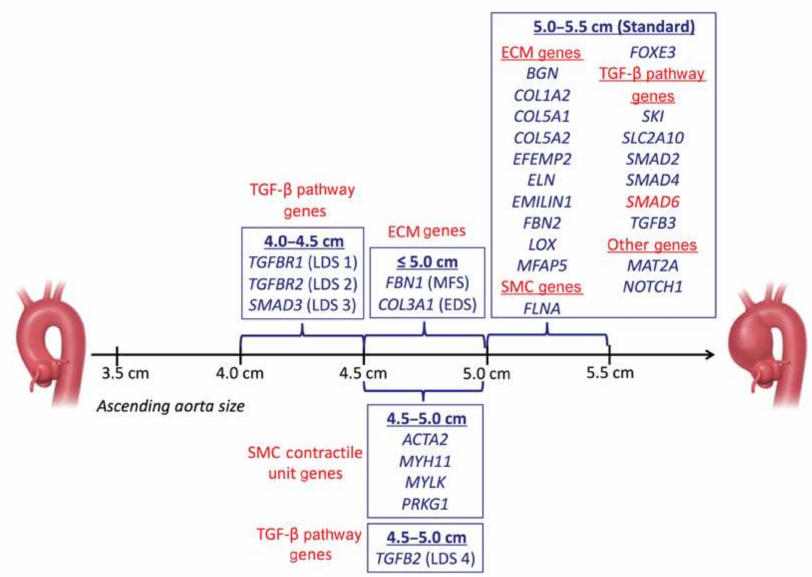
Figure 1. Ascending aortic dimensions for prophylactic surgical intervention. Abbreviations: ECM, extracellular matrix; SMC, smooth muscle cell; TAAD, thoracic aortic aneurysm and / or dissection; TGF, transforming growth factor. © 2020 by Thieme Medical Publishers Inc.